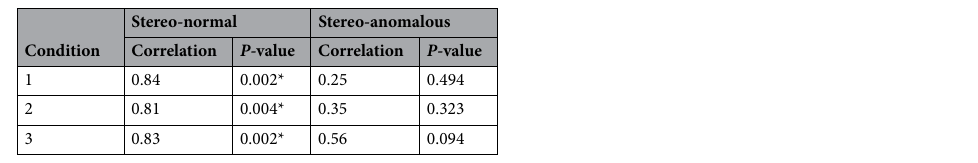
Table 4. Pearson’s correlation and P -values for PPR and initial stereoacuity threshold for each group and cue scaffolding